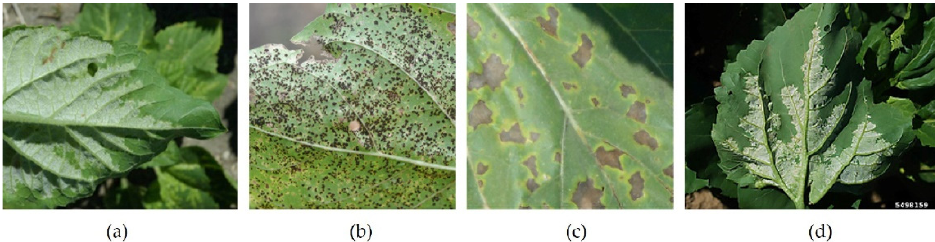
Figure 6. Confusion matrix without normalization.